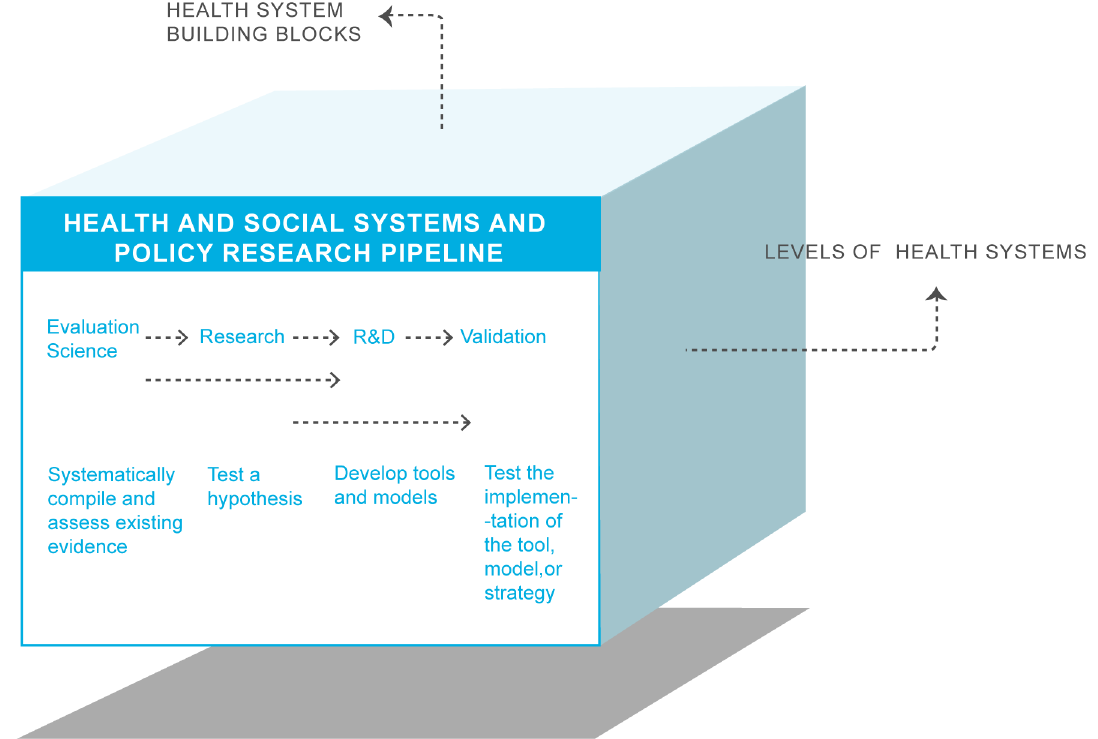
Fig 1. Researchagenda cube for health systemsand policy research. R&D, researchand